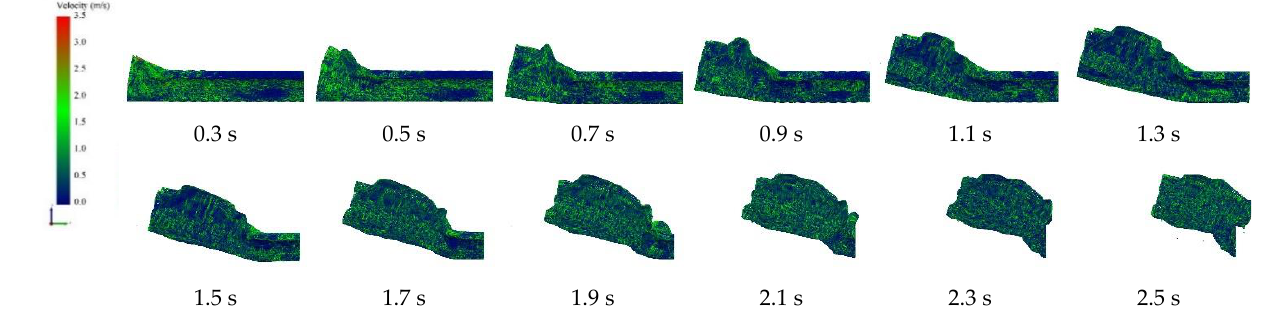
Figure 10. Film shapes at different times under the action of the elastic teeth film-lifting parts. As shown in Figure 10, in 0.3~0.5 s, One side of the mulch film is cut off and lifted. The velocity of most lifted mulch film particles is within 1.5~2.5 m/s. The lifting effect of the mulch film in the vertical direction is not obvious. In 0.7~1.3 s, the mulch film is gradually lifted. In 1.3~2.5 s, the mulch film has Z-axis direction lifting and the horizontal operation direction (Y-axis positive direction) gathered effect. The simulation process shows that the mulch film was moved forward by the elastic teeth film-lifting parts, the film is wrapped forward as a whole, and part of the film was damaged and passes through the gap between the elastic teeth film-lifting parts. The overall velocity of the mulch film was relatively high, but the film does not lift significantly along the Z-axis, which was not conducive